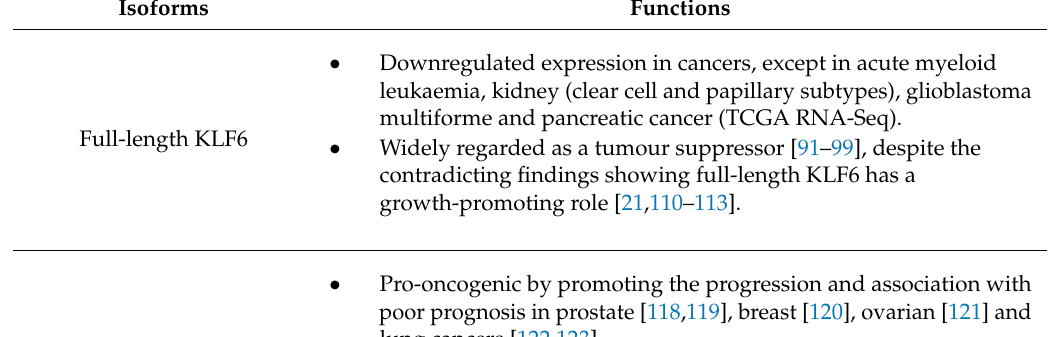
Table 1. The functional roles of full-length KLF6 and KLF6 spliced variants in cancer. Isoforms Functions Downregulated expression in cancers, except in acute myeloid leukaemia, kidney (clear cell and papillary subtypes), glioblastoma multiforme and pancreatic cancer (TCGA RNA-Seq). Full-length KLF6 • Widely regarded as a tumour suppressor [91–99], despite the contradicting findings showing full-length KLF6 has a growth-promoting role